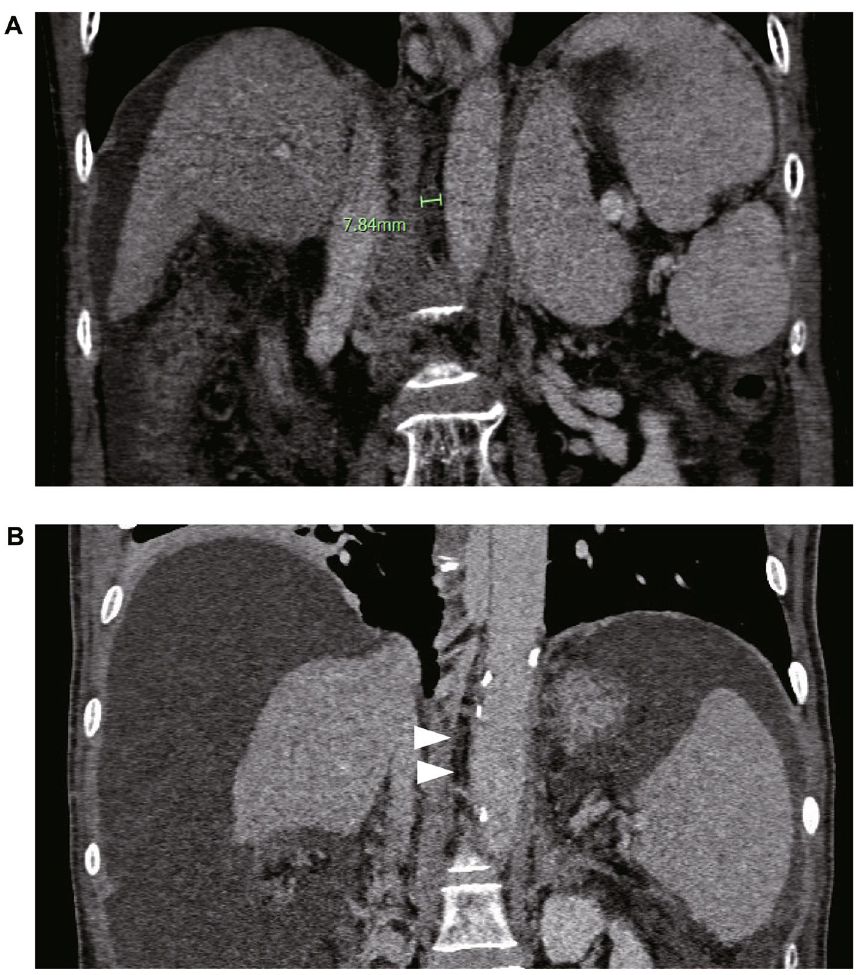
Figure 3. Cisterna chyli patterns. ( A ) Dilatated cisterna chyli (at measure point). ( B ) Narrowing cisterna